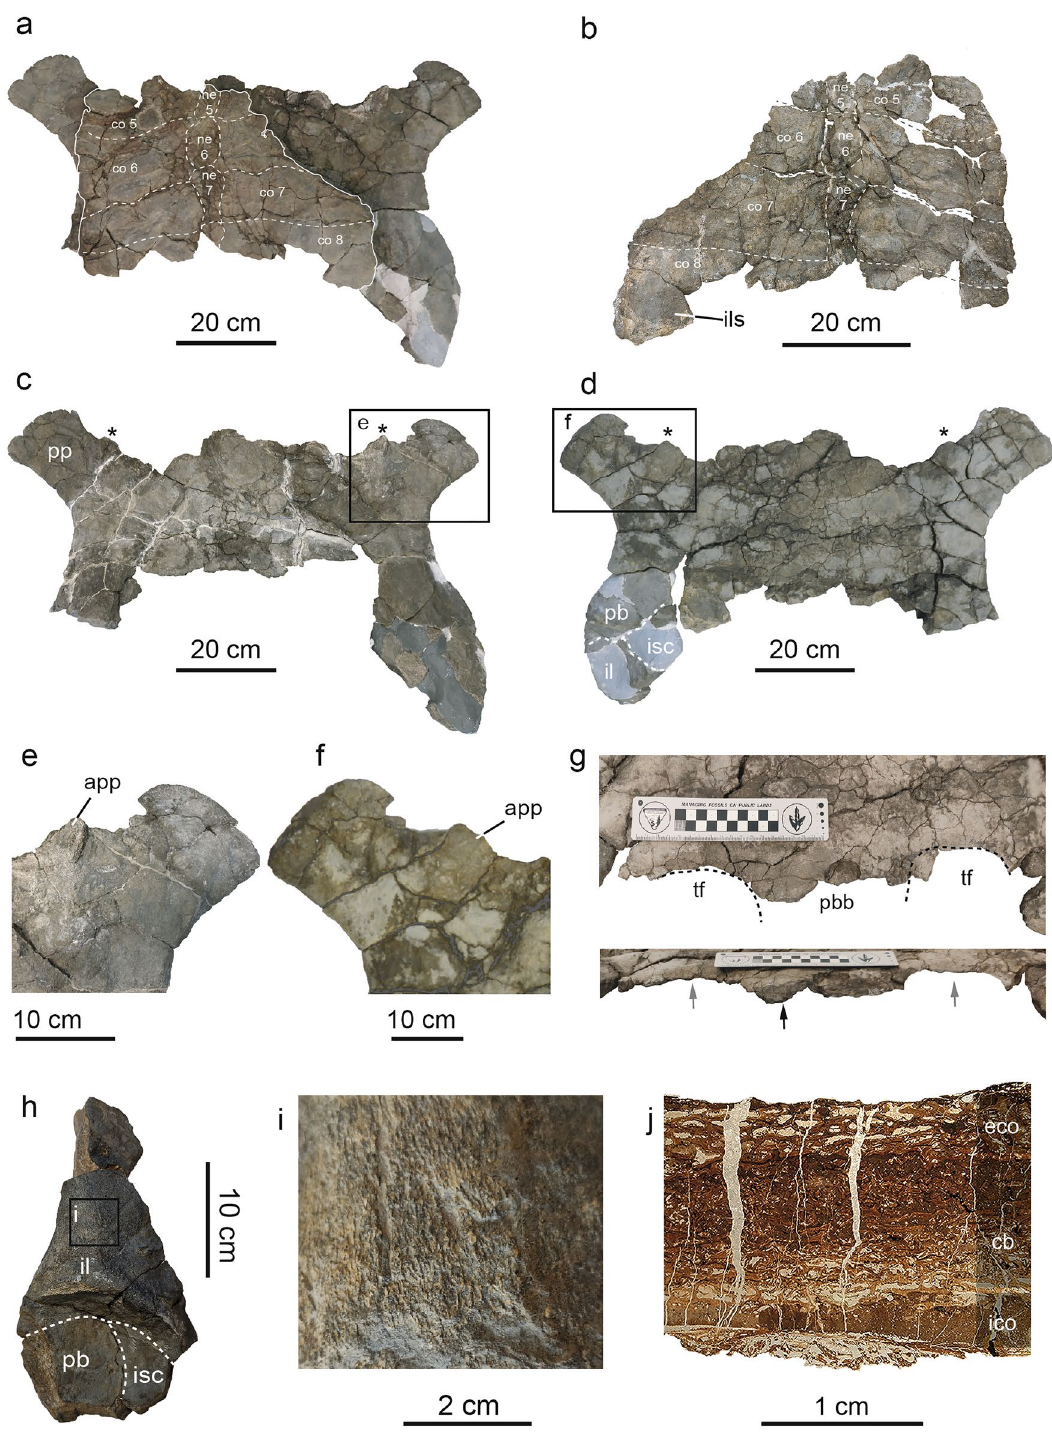
Figure 2. Shell and pelvic girdle elements of Leviathanochelys aenigmatica gen. et sp. nov. ( a ) Dorsal view of MCD9884 with the elements disposed as they were discovered, remarking in white the preserved carapace portion (MCD9884a). ( b ) Visceral view of the carapace with a superimposed interpretation of the shell elements. ( c ) Dorsal view of the preserved pelvic girdle without the carapace, and ( d ) ventral view of the same element with the carapace. Asterisk marks indicate the location of the autapomorphic accessory pubic process. Details of the accessory pubic process in ( e ) dorsal and ( f ) ventral view. ( g ) Close up view of the posteromedial part of the pubes, in ventral (upper picture) and posterior view (lower picture), preserving part of the thyroid fossae separated by a thick bone structure (black arrow). ( h ) Ventral view of the left acetabulum, illustrating the limits between the pelvic bones. ( i ) Detail of the outer ornamented surface of the ilium. ( j ) Histological section of the costal 8 (MCD9884.1), showing a cancellous bone zone between the highly vascularized internal and external cortices. Abbreviations: (ac) Acetabulum; (app) Accessory Pubic Process; (cb) cancellous bone; (co) costal plate; (eco) External Cortex; (ico) Internal Cortex; (il) Ilium; (ils) ilium insertion scar; (isc) Ischium; (il) Ilium; (ne) neural plate; (pb) Pubis; (pbb) pubic bridge; (tf) Thyroid